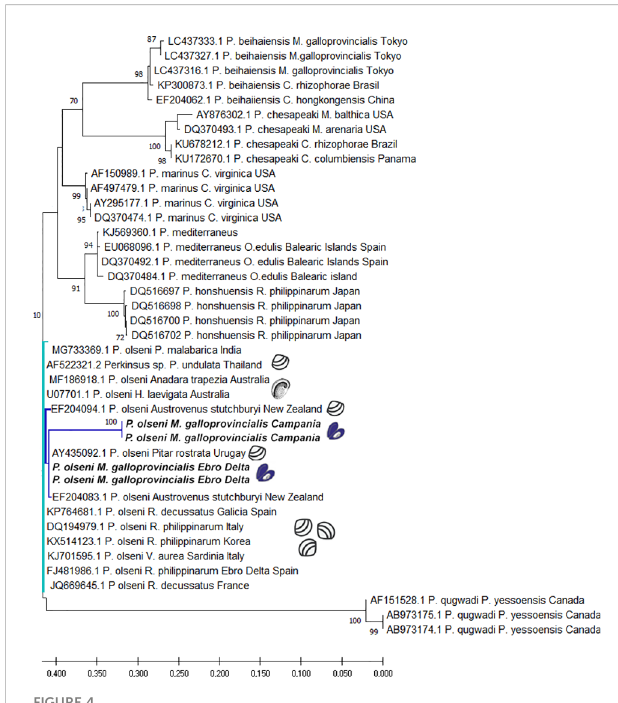
FIGURE 4 Evolutionary analysis by Maximum Likelihood method of Perkinsus spp. ITS sequences. The tree is drawn to scale, with branch lengths measured in the number of substitutions per site. This analysis involved 41 nucleotide sequences. There was a total of 794 positions in the fi nal